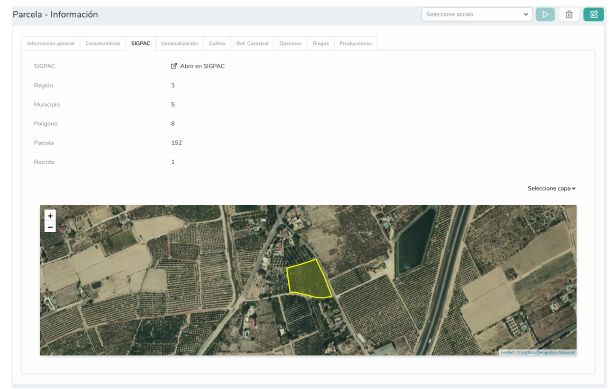
Figure 13. Plot geolocation